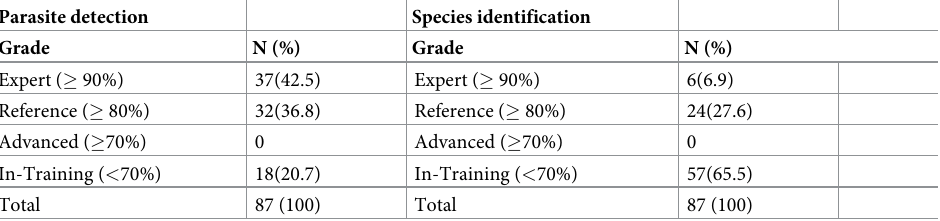
Table 5. Overall performance of laboratory professionals on Plasmodium detection a and species identification with their classification based on WHO recommendation at health facilities in Bahir Dar city administration from January to March